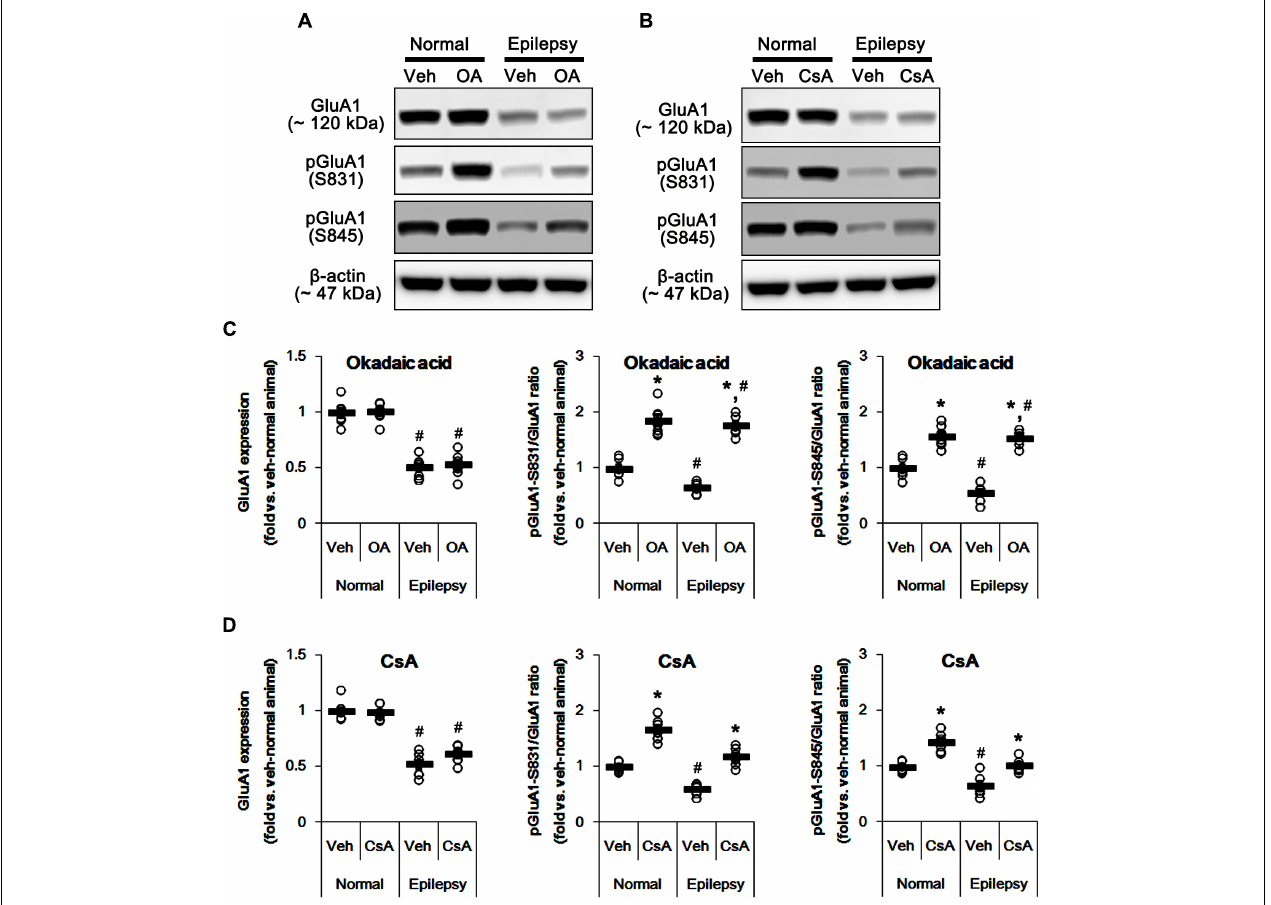
FIGURE 11 | Effects of okadaic acid (OA) and CsA on GluA expressions and their phosphorylations. (A,B) Representative images for western blot of GluA1, phospho (p)-GluA1-S831, and pGluA1-S845 in the hippocampal tissues obtained from 3-days infused groups (B) . (C,D) Quantifications of GluA1, pGluA1-S831, and pGluA1-S845 levels in okadaic acid- (C) and CsA-infused groups (D) . Open circles indicate each individual value. Horizontal bars indicate mean value. Error bars indicate SEM ( ∗ , # p < 0.05 vs. vehicle-treated animals and normal animals, respectively; n = 7,